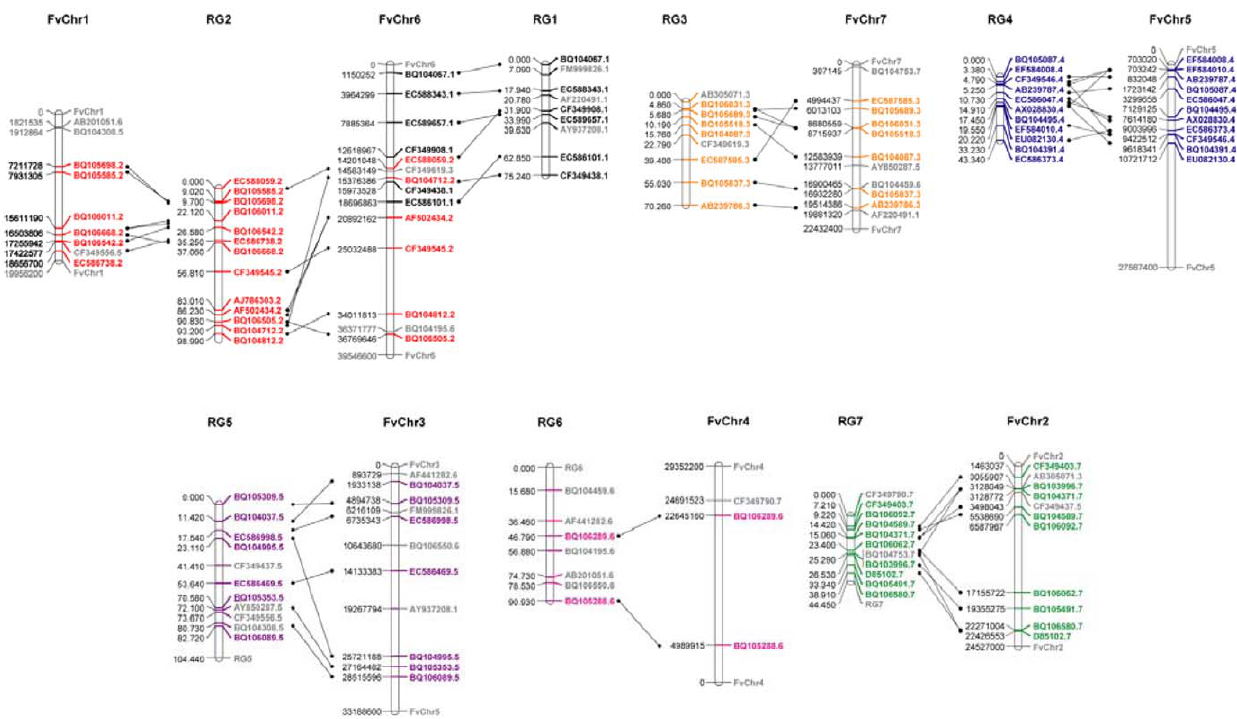
Figure 6. Comparison between the Rosa FC linkage map and the pseudo-chromosomes of Fragaria FvH4 genome sequence . Each group contains the map positions of the 70 orthologous markers used for comparison. Lines between Rosa linkage groups (RG) and Fragaria pseudo- chromosomes (FvChr) indicate marker positions within syntenic blocks. Map distances are given in cM, pseudo-chromosome positions are given in nucleotides. Marker names are given with the suffix according to the Rosa linkage group on which they are mapped. Markers common to syntenic blocks are given in the color of the Rosa linkage group; non-syntenic markers are given in grey. Delimiters defining the ends of the Fragaria pseudo- chromosomes and where necessary the Rosa linkage groups are given in grey with the pseudo-chromosome/linkage group name.